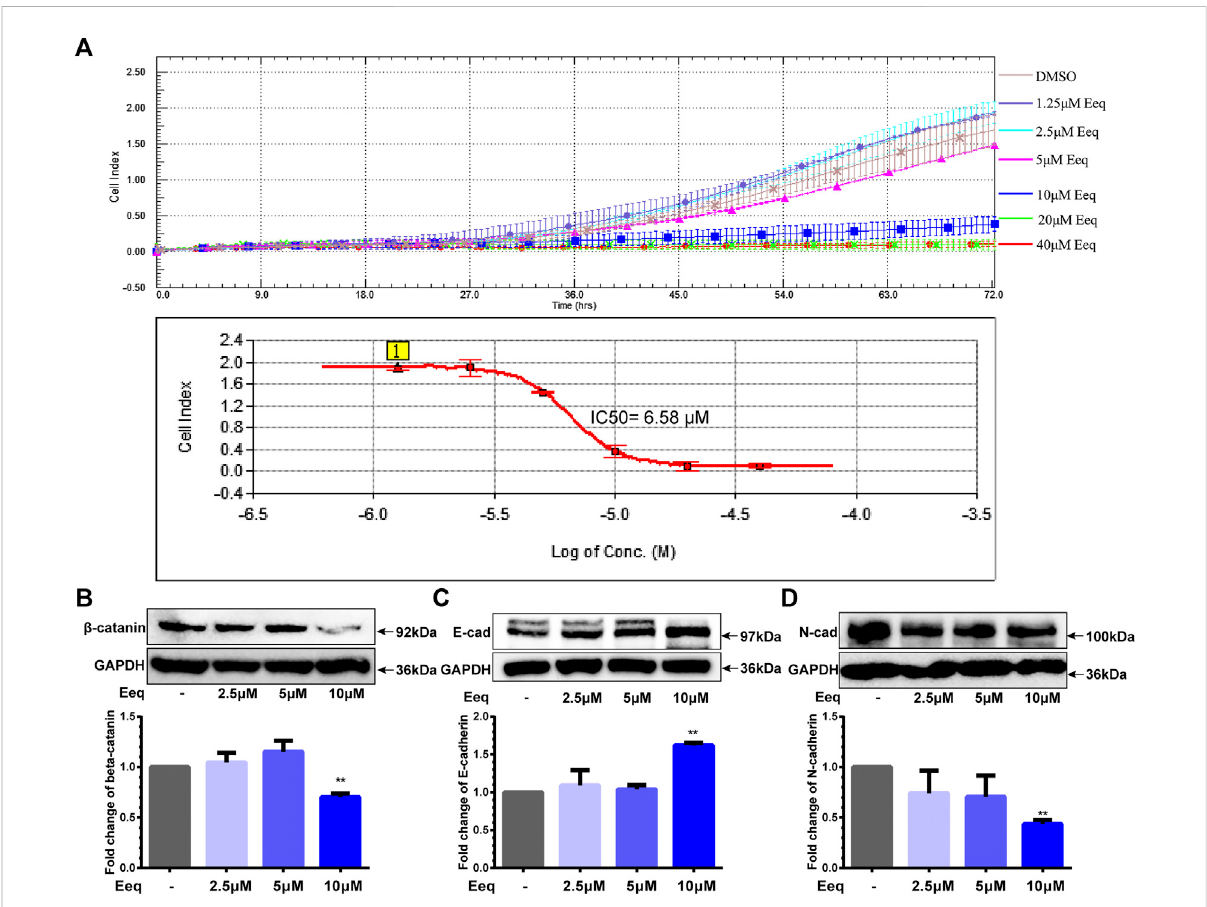
FIGURE 3 5 ′ -Epiequisetin(Eeq)inhibitedthemigrationofPC-3cells. (A) IC 50 ofEeqinhibited PC-3cell migration. (B) ImpactofEeqonproteinexpression of beta-catenin. (C) Impact of Eeq on protein expression of E-cadherin. (D) Impact of Eeq on protein expression of N-Cadherin. * p < 0.5, ** p < 0.01 vs.